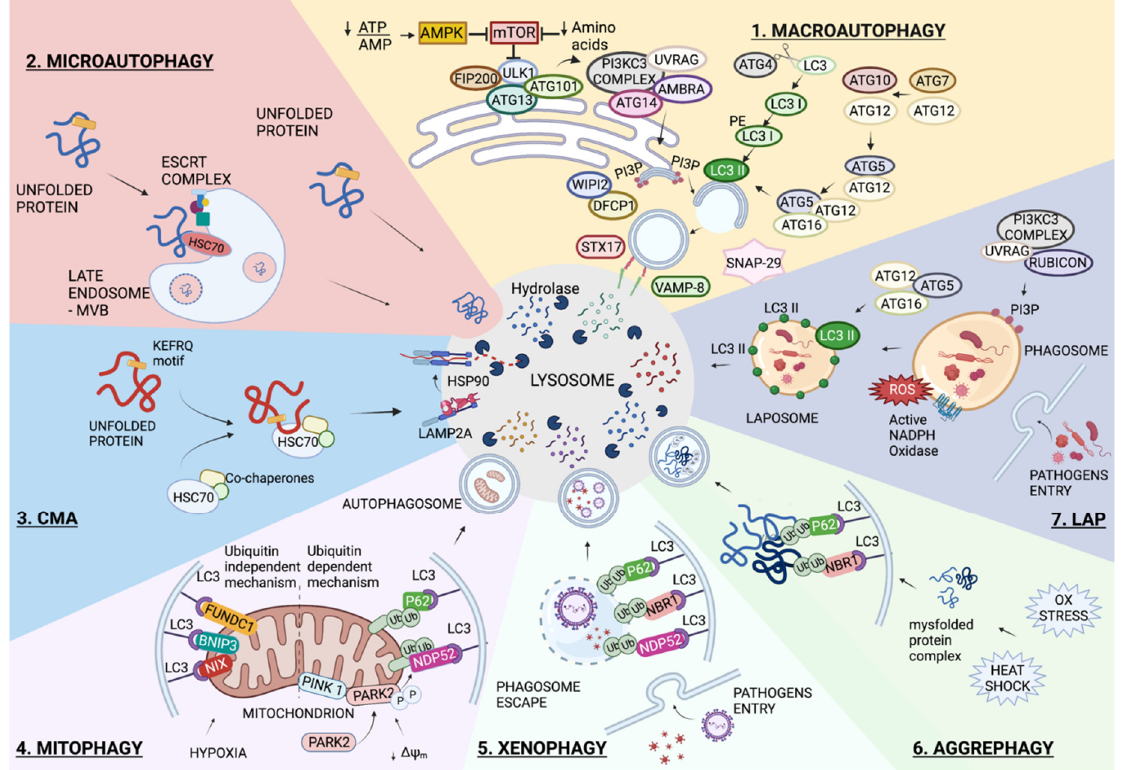
Figure 1. Autophagy overview. Schematic representation of the main autophagic pathways involved in lung infections and diseases. All these degradative pathways have the lysosomal degradation in common. 1. Macroautophagy is the non-selective degradation of intracellular content. The process starts with AMPK activation and/or MTOR inactivation. The recruitment of several complexes composed of ATG proteins orchestrates the formation of a double membrane vesicle called an autophagosome, and the enwrapped content is degraded following its fusion with a lysosome. 2. Microautophagy occurs through the direct invagination of the lysosomal membrane into the lumen. In endosomal microautophagy, the invagination of a late endosome membrane is mediated by the ESCRT complex, and a KFERQ-like motif on the substrate is recognized by HSC70. 3. Similar to endosomal microautophagy, Chaperone-Mediated Autophagy (CMA) requires KFERQ-like motifs on substrates that are recognized by HSC70; however, CMA also requires the LAMP2A lysosomal protein receptor to translocate the unfolded substrate into the lysosome lumen. The selective forms of autophagy require the formation of the autophagosome and differ according to the specificity of the substrate. 4. Mitophagy is the selective degradation of mitochondria, which can occur through the ubiquitin-dependent or ubiquitin-independent pathways. 5. Xenophagy is the selective removal of pathogens. 6. Aggrephagy refers to the degradation of cytoplasmic protein aggregates. 7. A non-canonical form of autophagy is represented by the LC3-Associated Phagophore, LAP. Pathogens are enclosed in a single-membrane vesicle, and ROS generated by NADPH oxidase (NOX) promotes the recruitment of LC3 to the phagosome. The formed LAPosome fuses with the lysosome for content degradation. More details are reported in the main text. Created with BioRender.com.